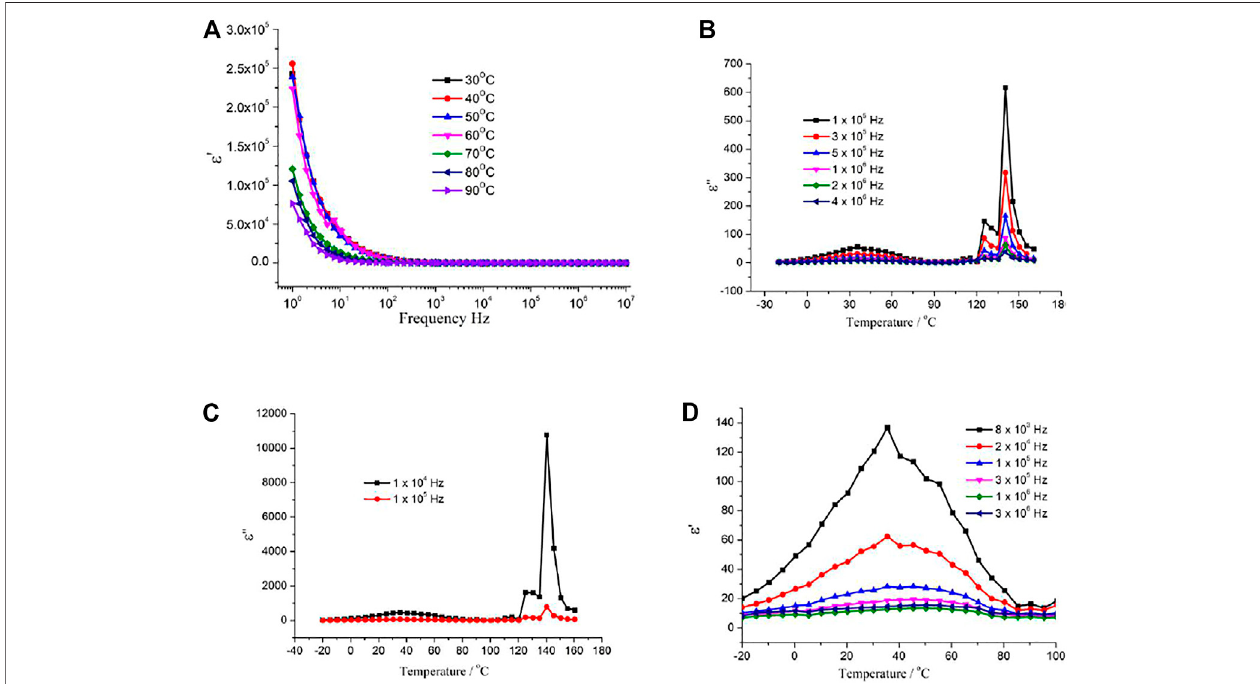
FIGURE 2 | (A) Frequency dependencies of ε ′ in the 30 ° C – 90 ° C temperature range; (B) and (C) temperature dependencies of ε ′ in the selected frequency range; and (D) temperature dependencies of ε ′ shows a broad dielectric peak below 100 ° C of 1 .